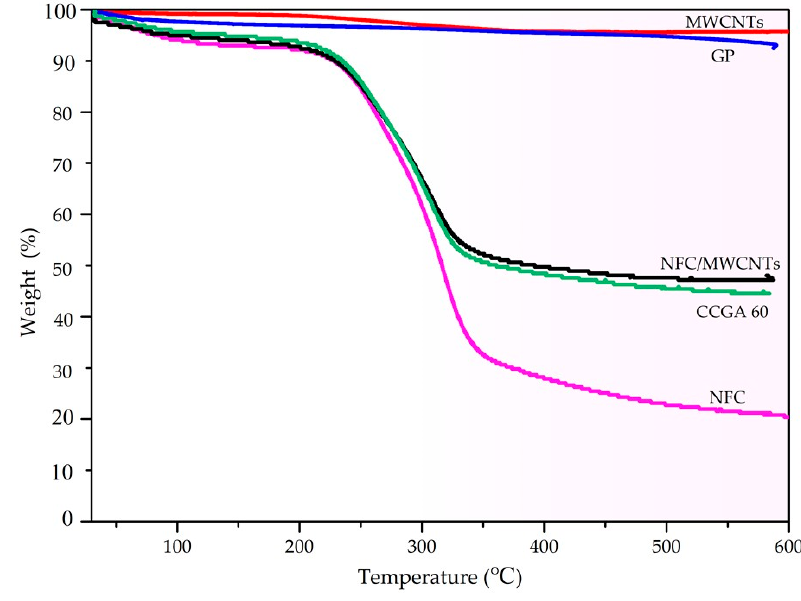
Figure 8. Thermogravimetric (TG) cures of the aerogels.